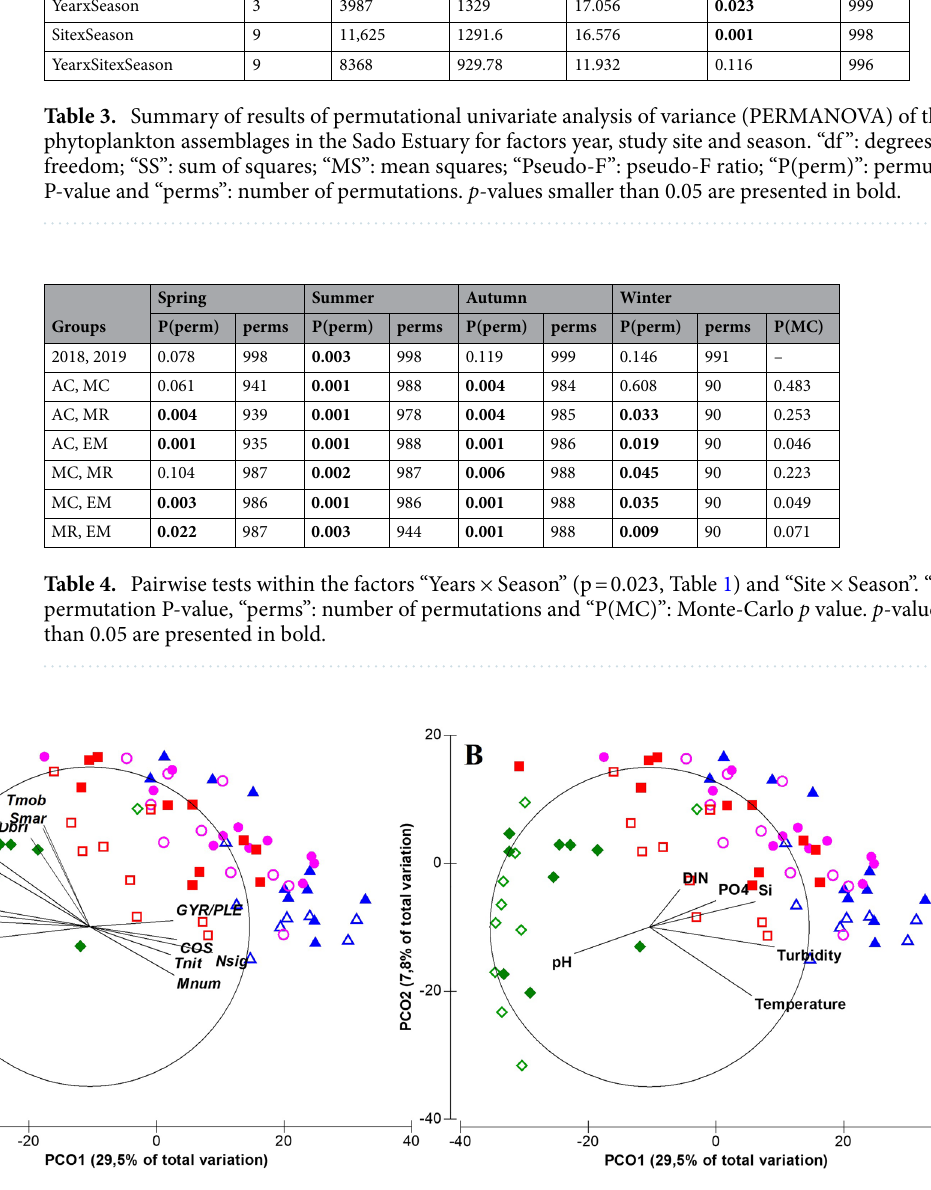
Figure 7. Principal coordinates analysis (PCO) plots of the abundance and composition of the phytoplankton community between each study site, based on a Bray–Curtis resemblance matrix. For each site, the symbols correspond to different sampling dates. ( A )—some of the taxonomic entities (abbreviated according to Table S2) with correlations above 0.5 are represented as vectors overlapping the ordination, and ( B )—physico-chemical variables with correlations above 0.2 with the PCO axes are represented as overlapping